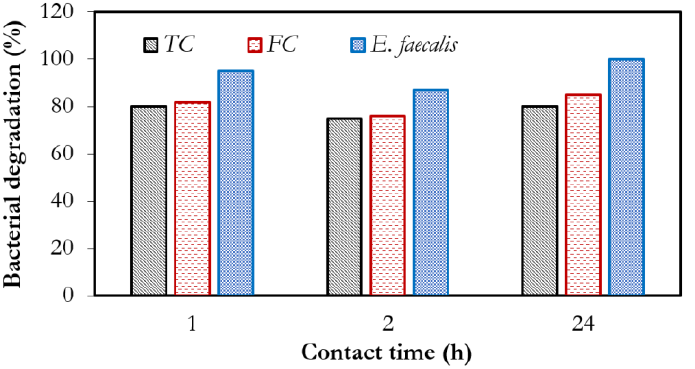
Figure 7. Contact times of 1, 2 and 24 h of CuO and their effects on TC, FC and E. faecalis degradation [114].